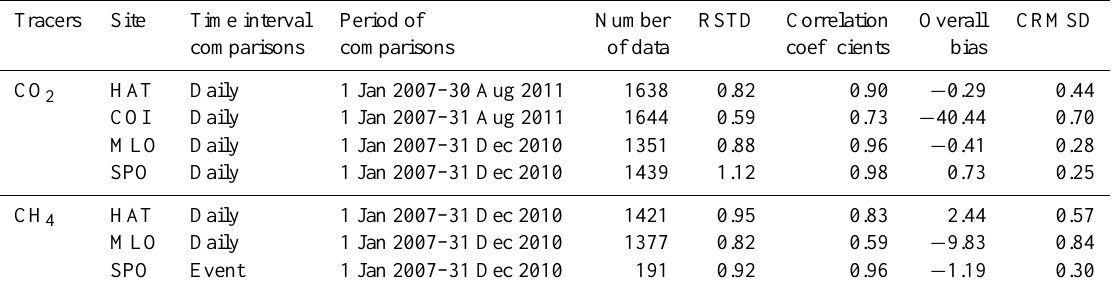
Table 2. Statistics to show the model performance against continuous measurements for daily-mean CO 2 and CH 4 at HAT (Hateruma), Cape Ochi-ishi (COI), MLO (Mauna Loa) and SPO (South Pole). Observed CH 4 data at SPO are discrete data and the simulated results corresponding to the measurement date are used for the comparisons. Statistics are defined as in Table 1. Tracers Site Time interval Period of Number RSTD Correlation Overall CRMSD comparisons comparisons of data coefficients bias